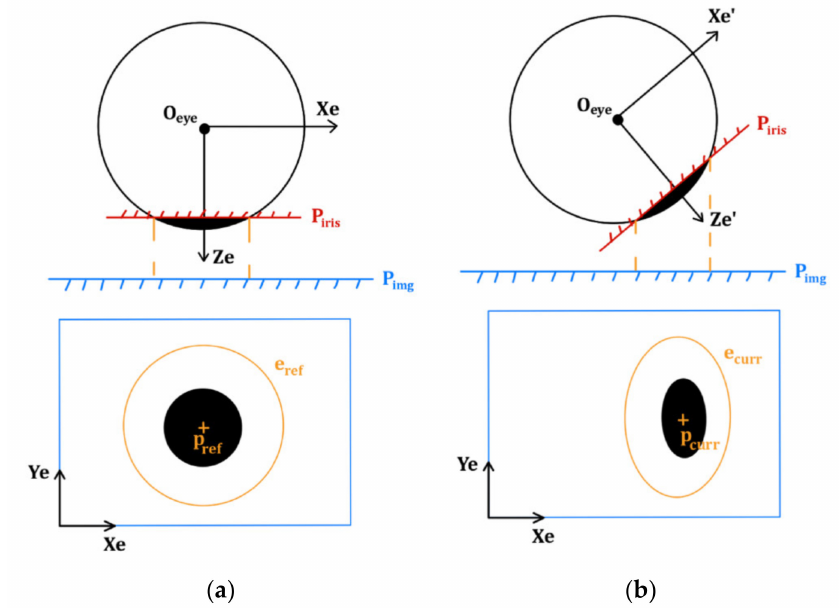
(cid:16) (cid:17) O eye , Xe − Ye − Ze at referent position. The iris